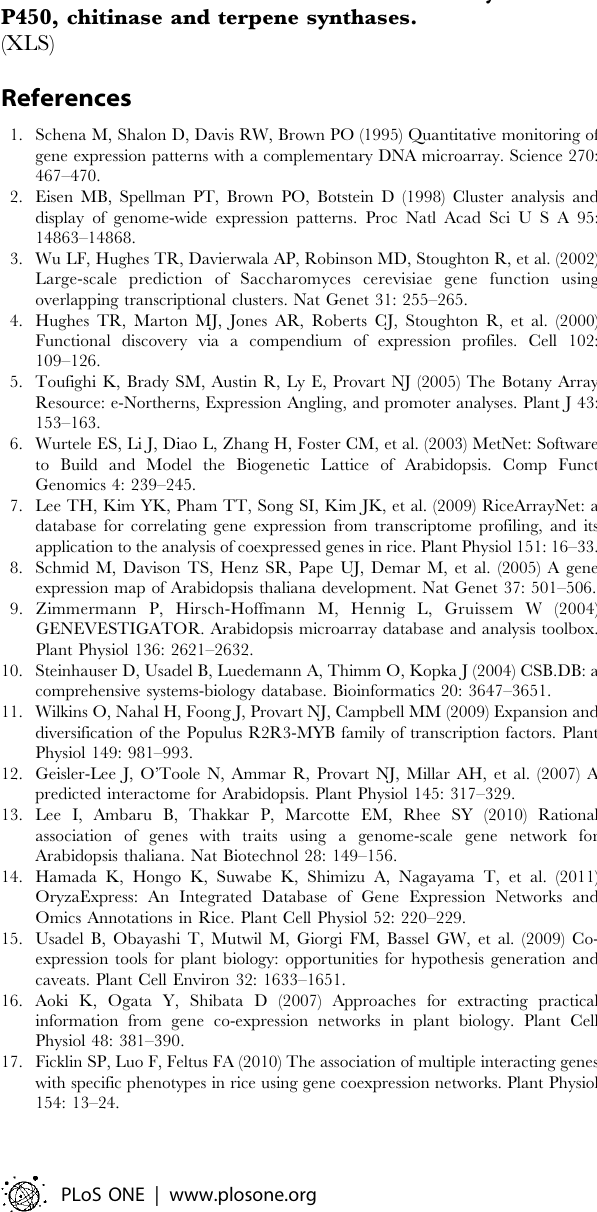
Table S6 List of module names, member genes and gene functional annotations from condition-independent network analysis. Table S7 Pfam domain enrichment within condition- independent gene coexpression modules. Table S8 Overlap of genes between condition-depen- dent gene modules and condition-independent gene